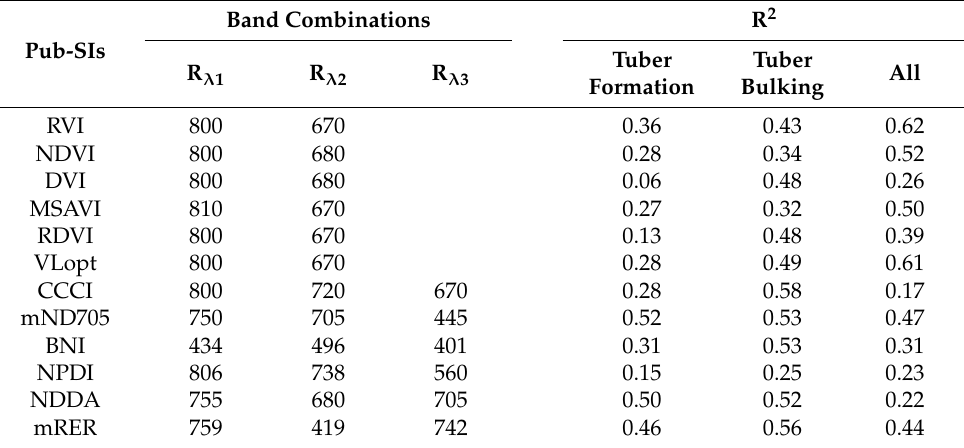
Table 2. The band (nm) combination of published spectral indices (Pub-SIs) and corresponding relationships between Pub-SIs and potato AGB at different growth stages.